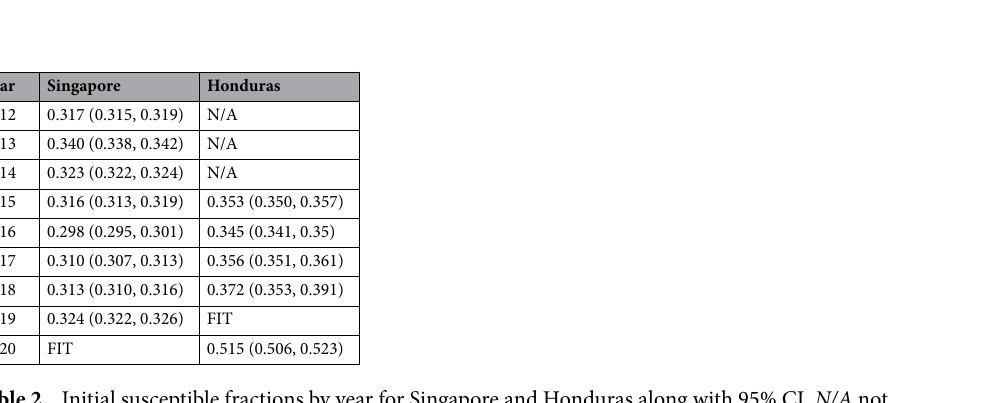
Table 2. Initial susceptible fractions by year for Singapore and Honduras along with 95% CI. N/A not applicable, Fit years of fit for the mod.